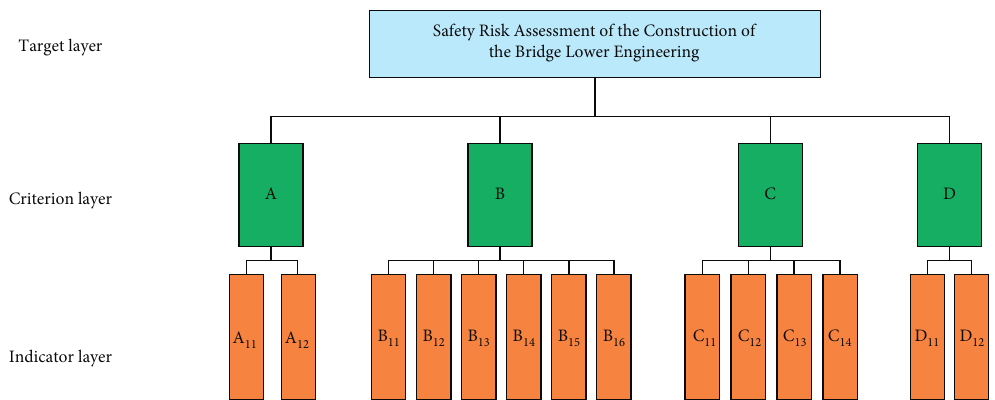
Figure 5: The hierarchical structure model of the safety risk assessment of the project under the pile of the Yinzhou lake bridge. Table 14: Judgment matrix of the objective layer-criterion layer. Table 15: Average random consistency